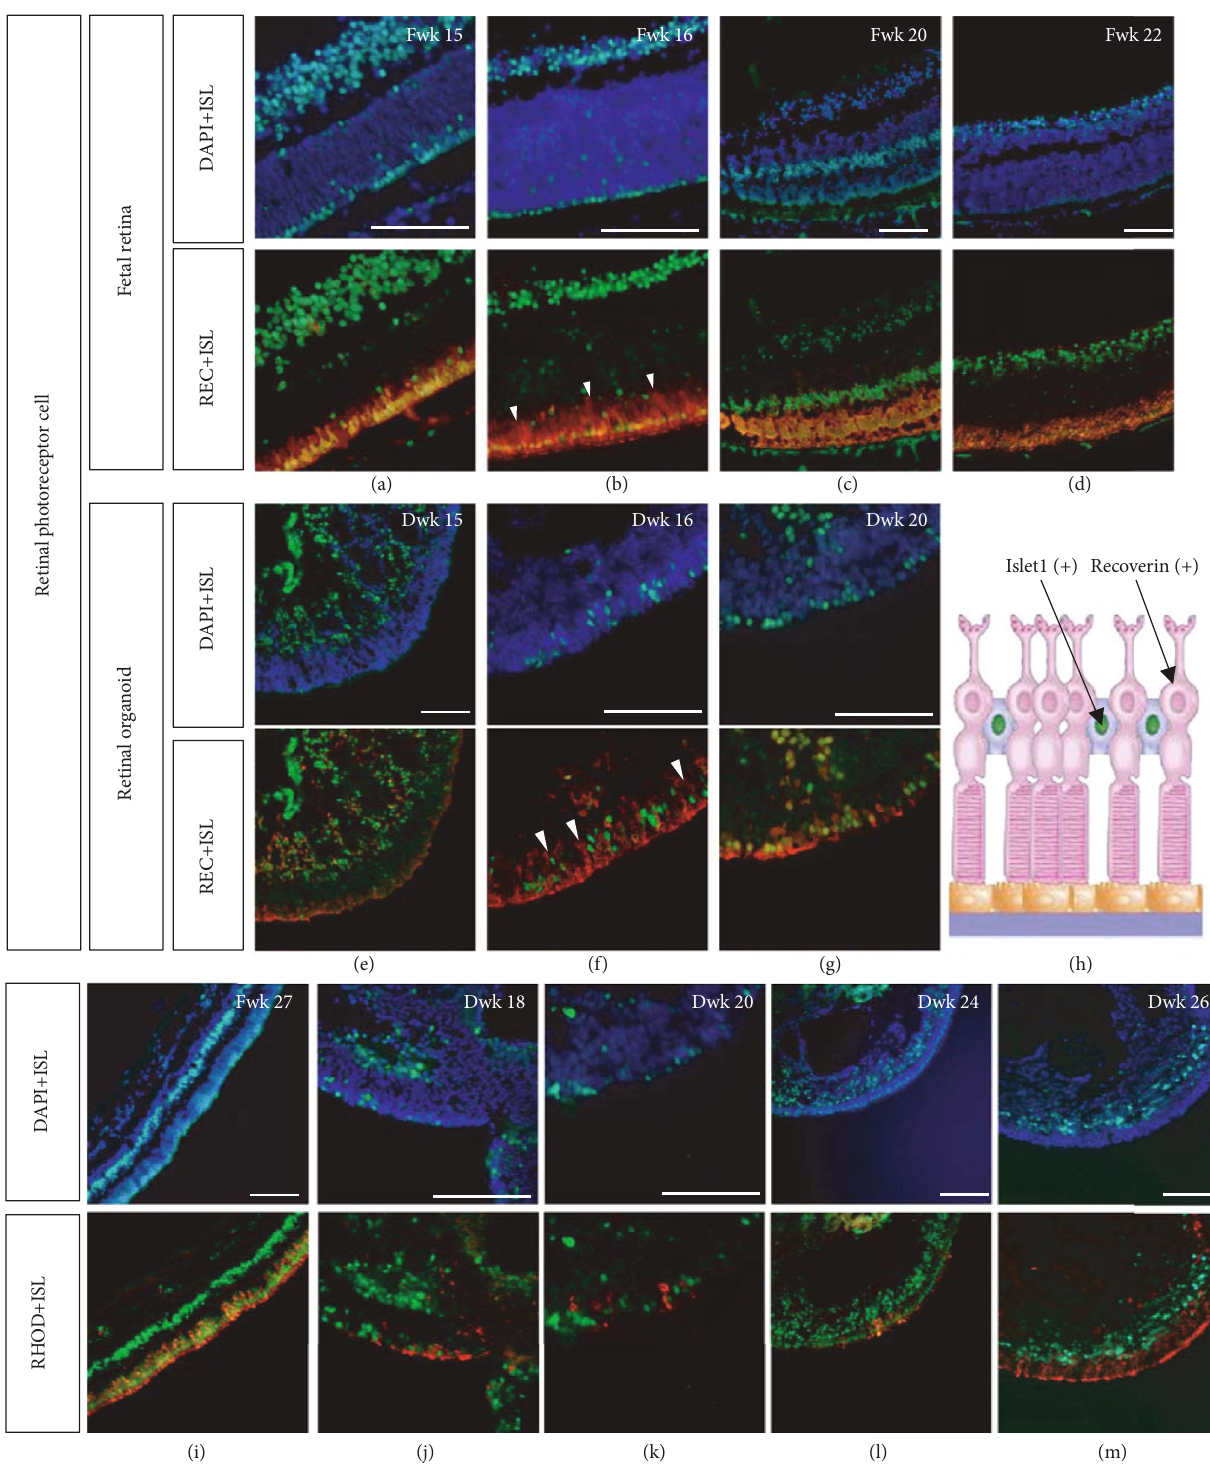
Figure 8: Isl1 expression in developing photoreceptor cells. (a – d) A monolayer of Islet1 immunoreactive nuclei was observed from Fwk 15; the cells were Recoverin positive. However, as indicated by the white triangle, some Recoverin-positive cells were Islet1 negative, and their nuclei were located on the inner side to Islet1-positive cells. (e) In Dwk 15, Recoverin-positive developing photoreceptors were migrating from the basal side to the apical side. (f) Similar to in the fetal retina, some developing photoreceptors with inner arranged nuclei were Recoverin positive but Islet1 negative. (g – h) Developing photoreceptors in the retinal organoid. (i) In Fwk 27, cells with inner arranged nuclei were Rhodopsin-positive rods, and the Islet1-nuclei were between the soma and inner segment of rods as the schematic diagram (h). (j – m) Rod di ff erentiation in retinal organoids ( scale bar = 100 μ m